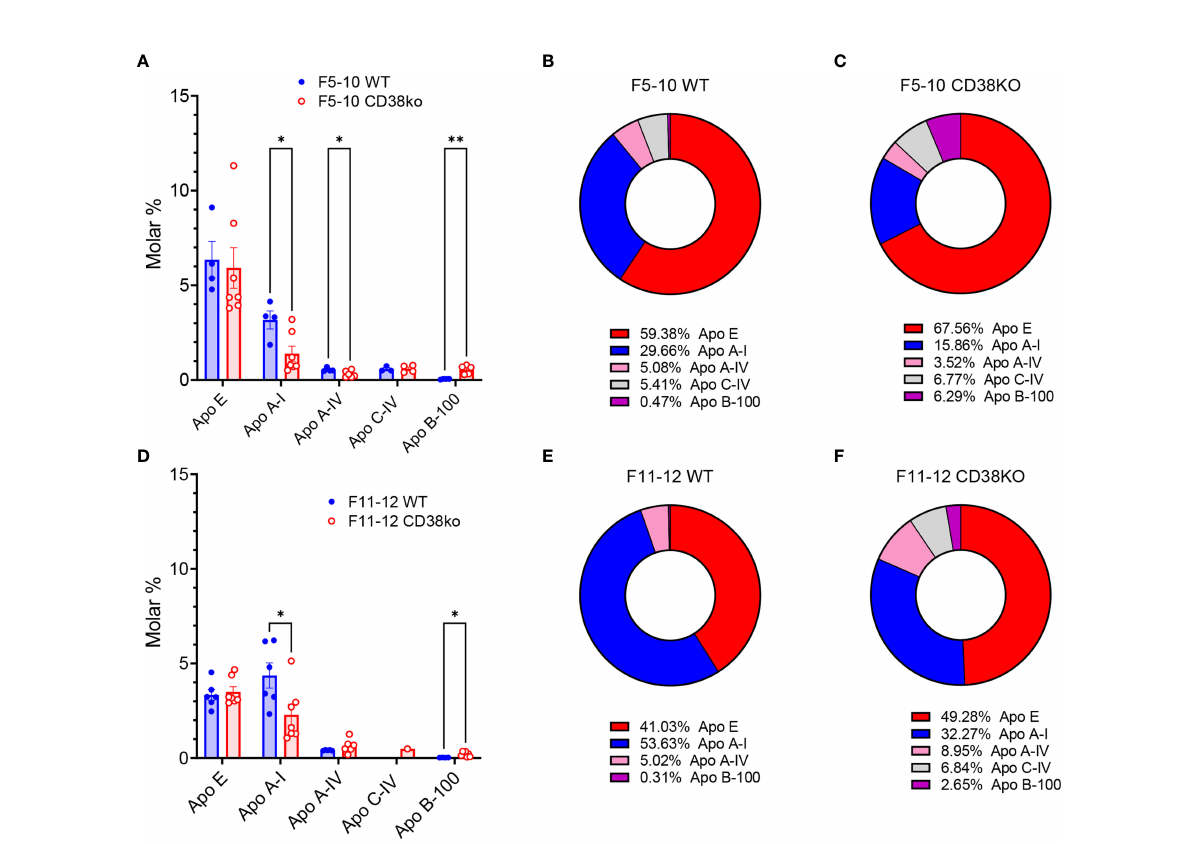
FIGURE 9 (A) Molar percentages of the apolipoproteins identi fi ed in F5-10 WT EV versus F5-10 Cd38 -/- EV. Histograms represent the mean values, and the bars ± SEM. Unpaired t-test. Each circle represents a technical replicate from pooled biological samples. (B) Relative protein abundance (as percentages of total M%) of the apolipoproteins identi fi ed in F5-10 WT EV. (C) Relative protein abundance (as percentages of total M%) of the apolipoproteins identi fi ed in F5-10 Cd38 -/- EV. (D) Molar percentages of the apolipoproteins identi fi ed in F11-12 WT EV versus F11-12 Cd38 -/- EV. Histograms represent the mean values, and the bars ± SEM. Unpaired t-test. Each circle represents a technical replicate from pooled biological samples. (E) Relative protein abundance (as percentages of total M%) of the apolipoproteins identi fi ed in F11-12 WT EV. (F) Relative protein abundance (as percentages of total M%) of the apolipoproteins identi fi ed in F11-12 Cd38 -/- EV. * = P < 0.05; ** = P < 0.01; Multiple unpaired